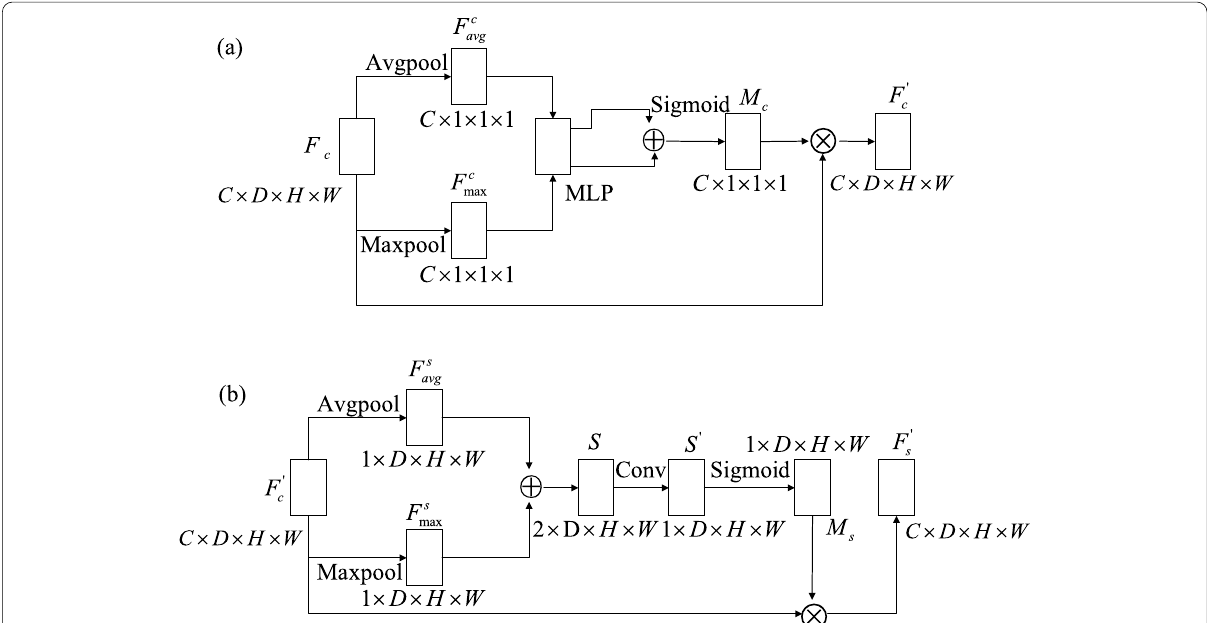
Fig. 4 The complete CBAM module. a Structure diagram of channel attention module; b Structure diagram of spatial attention